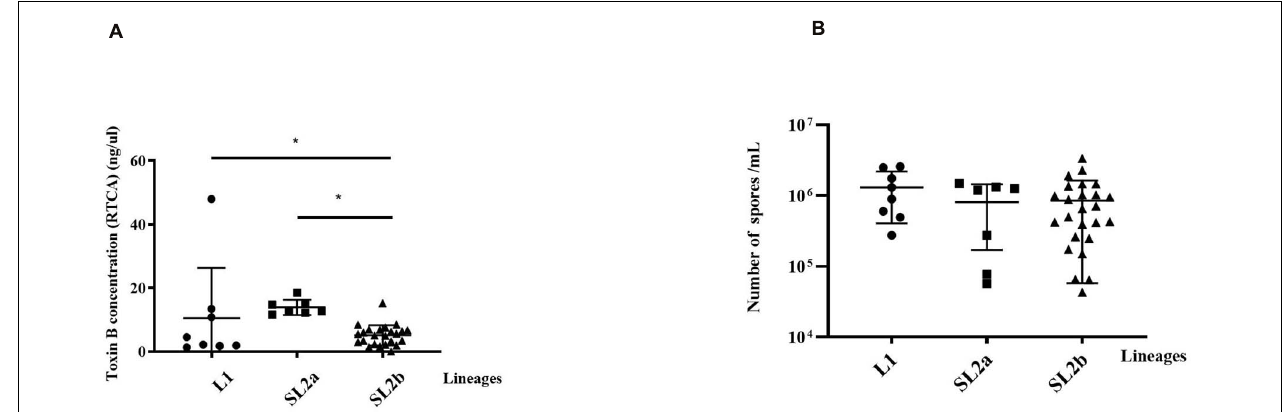
FIGURE 4 | Comparison of toxin production and Sporulation determination in the 40 C. difficile ST2 strains with different sub-lineages. (A) Toxin B concentrations by the RTCA system; (B) sporulation capacity by the heat-induced experiment. The toxin concentrations and sporulation capacity were shown as the mean ± standard deviation. Significant differences were marked with * P <